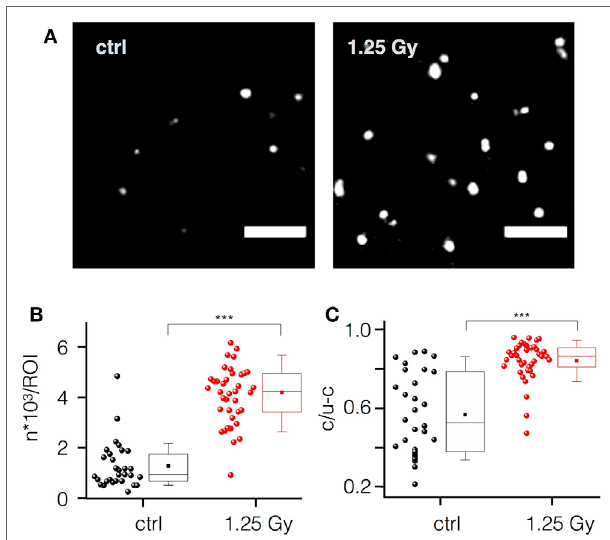
FigUre 5 | Ionizing irradiation increases integrin β 1 expression and clustering in Jurkat cells. (a) Localization of single integrin β 1 molecules and their organization as clusters in plasma membrane areas of non-irradiated (control) and irradiated (1.25 Gy) Jurkat cells visualized by high-resolution microscopy (scale bar = 1 µm). (B) Mean number of molecules per region of interest (ROI) in control cells (black circles) and in irradiated cells (red circles). (c) Ratio of clustered versus non-clustered integrin β 1 molecules in irradiated and non-irradiated cells. Each point in (B,c) represents data from one ROI of an image. Box plot symbols have the same meaning as in Figure 2